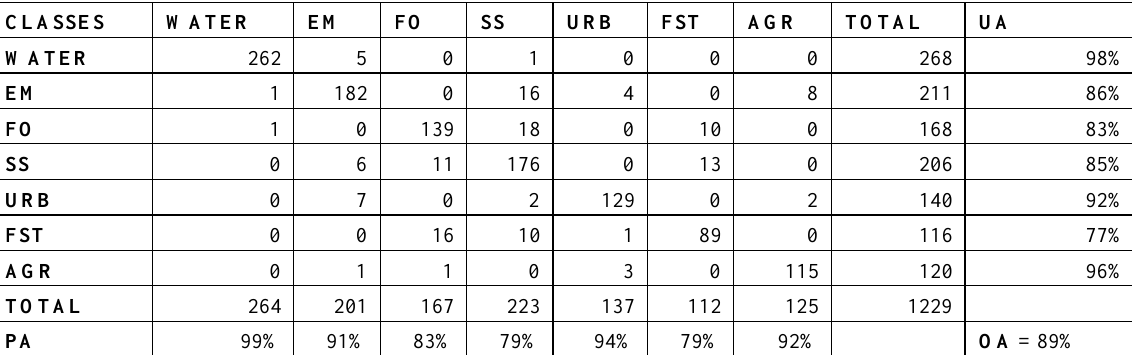
Table 3. Classification error matrix for random forest classifier after Sentinel-1 C-band radar was added.